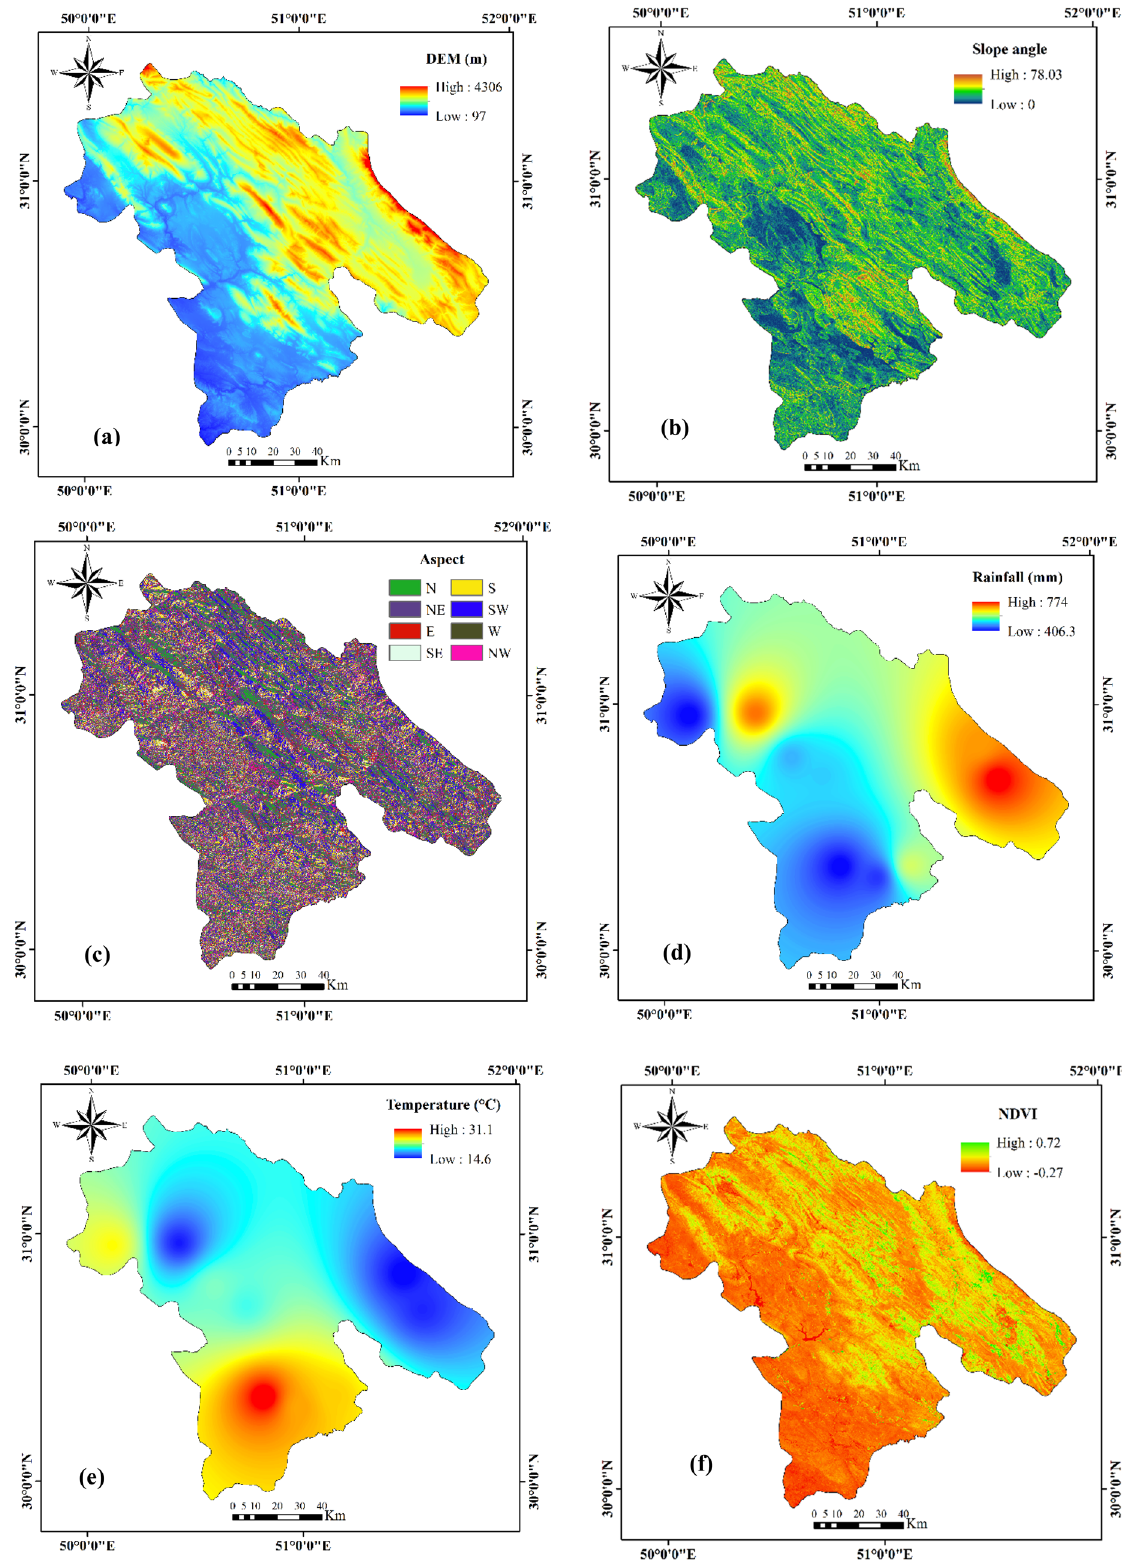
Figure 9. Maps of hazard factors used in this